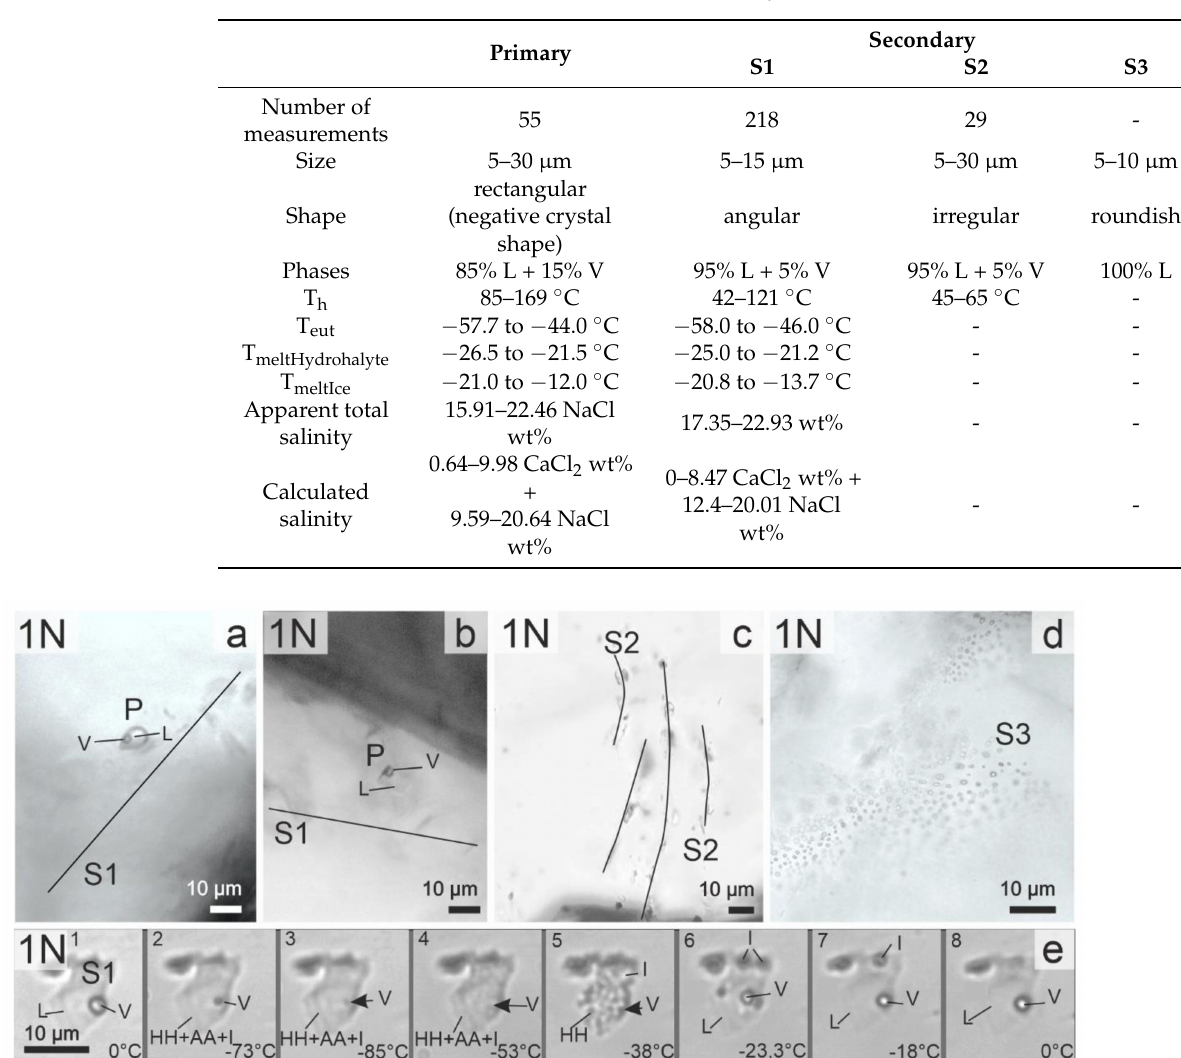
Table 2. Results of the fluid inclusion microthermometry.